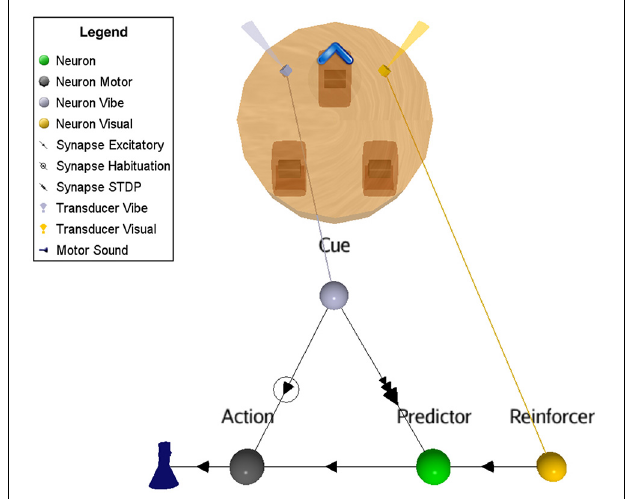
FIGURE 4 | Suggested ASNN to achieve OC procedures in varying contexts with a minimal component requirement. This specific situation results in increased behavior when followed by a reinforcer. The positive reinforcer consists of light perceived from a visual sensory neuron. The action is simulated with a sound